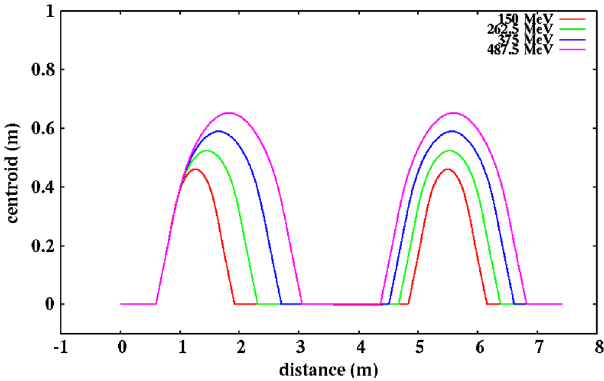
FIG. 3. Horizontal centroid ( h x i ) trajectories of four energy passes through the phase shifter using the field distribution from the Table